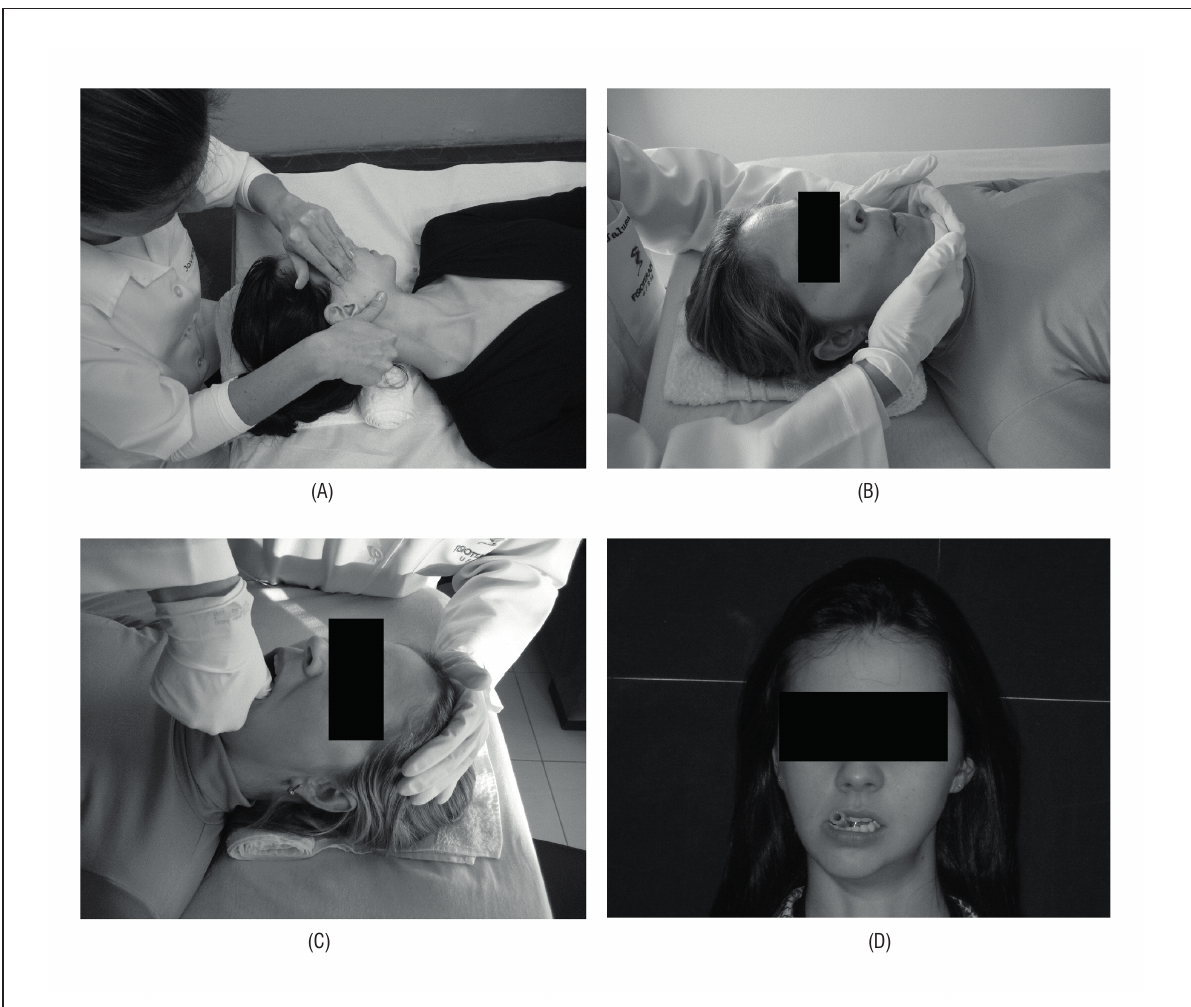
Figure 1 - (A) Myofascial release of the masseter muscle; (B) Stretching of jaw elevator muscles (C) Mobilization of TMJ: (D) Neuromuscular exercises Source: Research